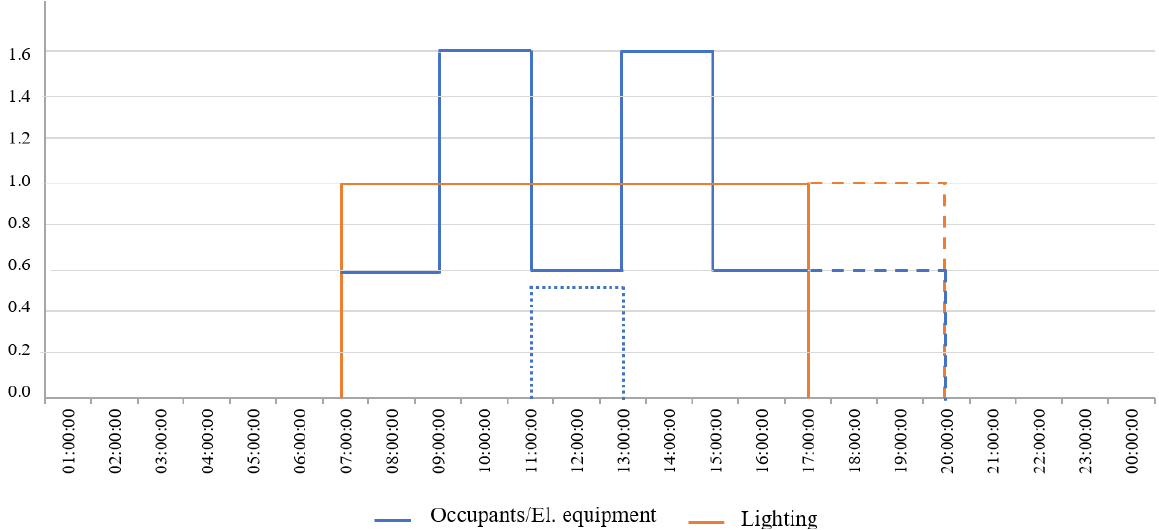
Figure A1. Profile schedules used for occupancy, electric equipment, and lighting in the analysed scenarios. * The dashed blue and orange lines denote scenarios 2, 3, 7, and 8, which imply a longer stay of occupants in specific rooms. ** The dotted blue line denotes the occupation profile for the canteen, which is the only zone whose occupation differs from the rest of the modelled zones.